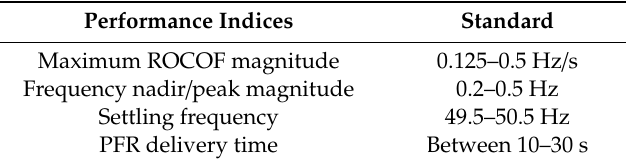
Table 3. Performance indices for IR and PFR.